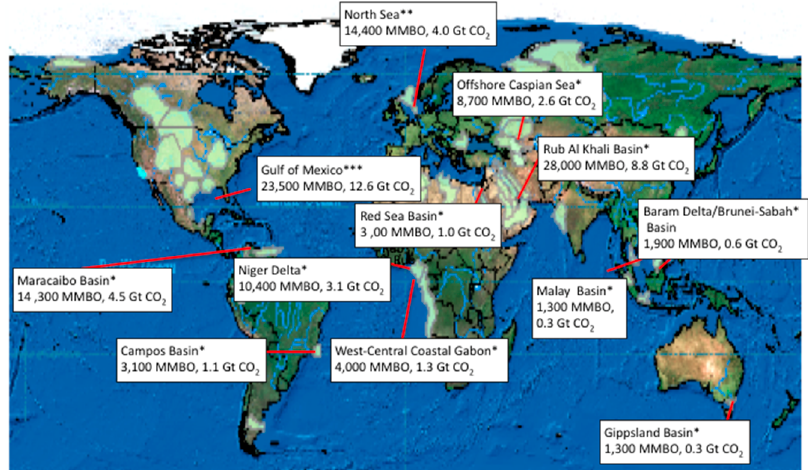
Figure 2. Basins for which the potential for incremental oil production and CO 2 storage have been assessed. Sources: * IEAGHG (2009) [16]; ** Pershad et al. (2013) [5]; and *** IEAGHG (2016) [12].